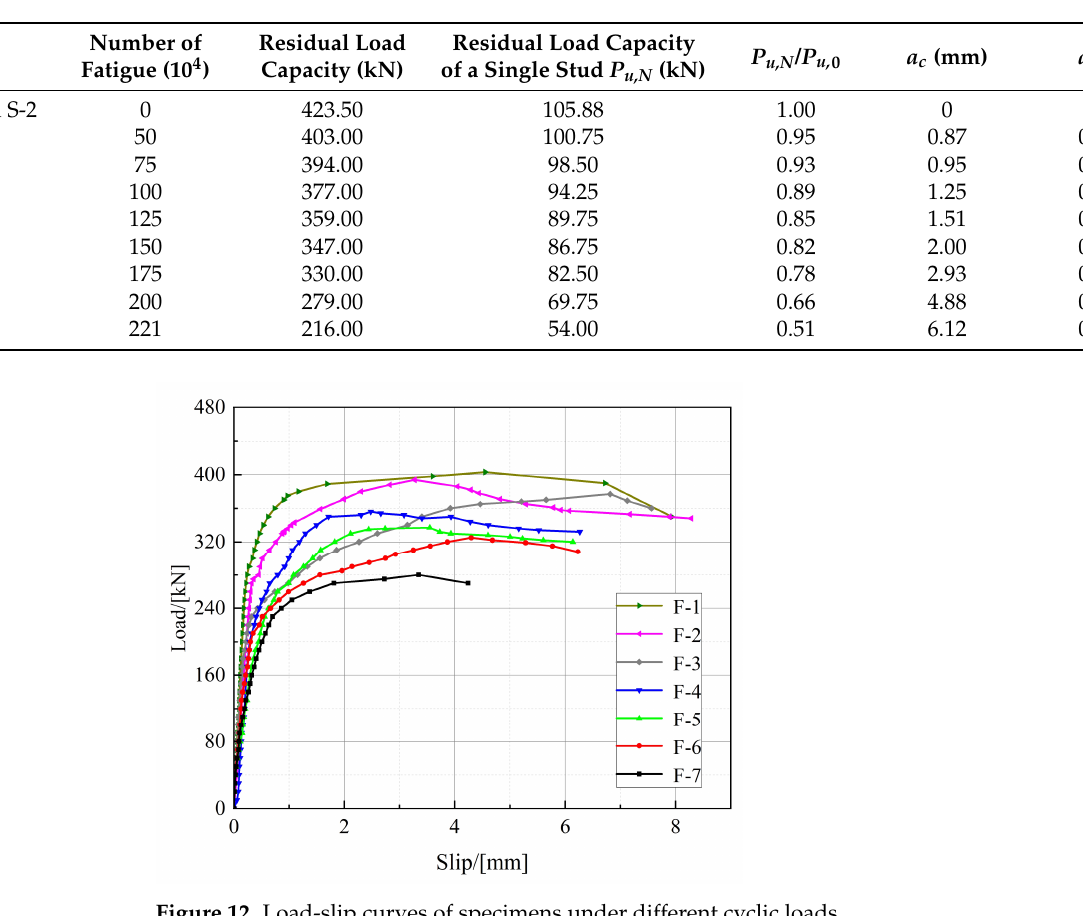
Figure 13. Relationship between P u,N /P u, 0 and a c /d .